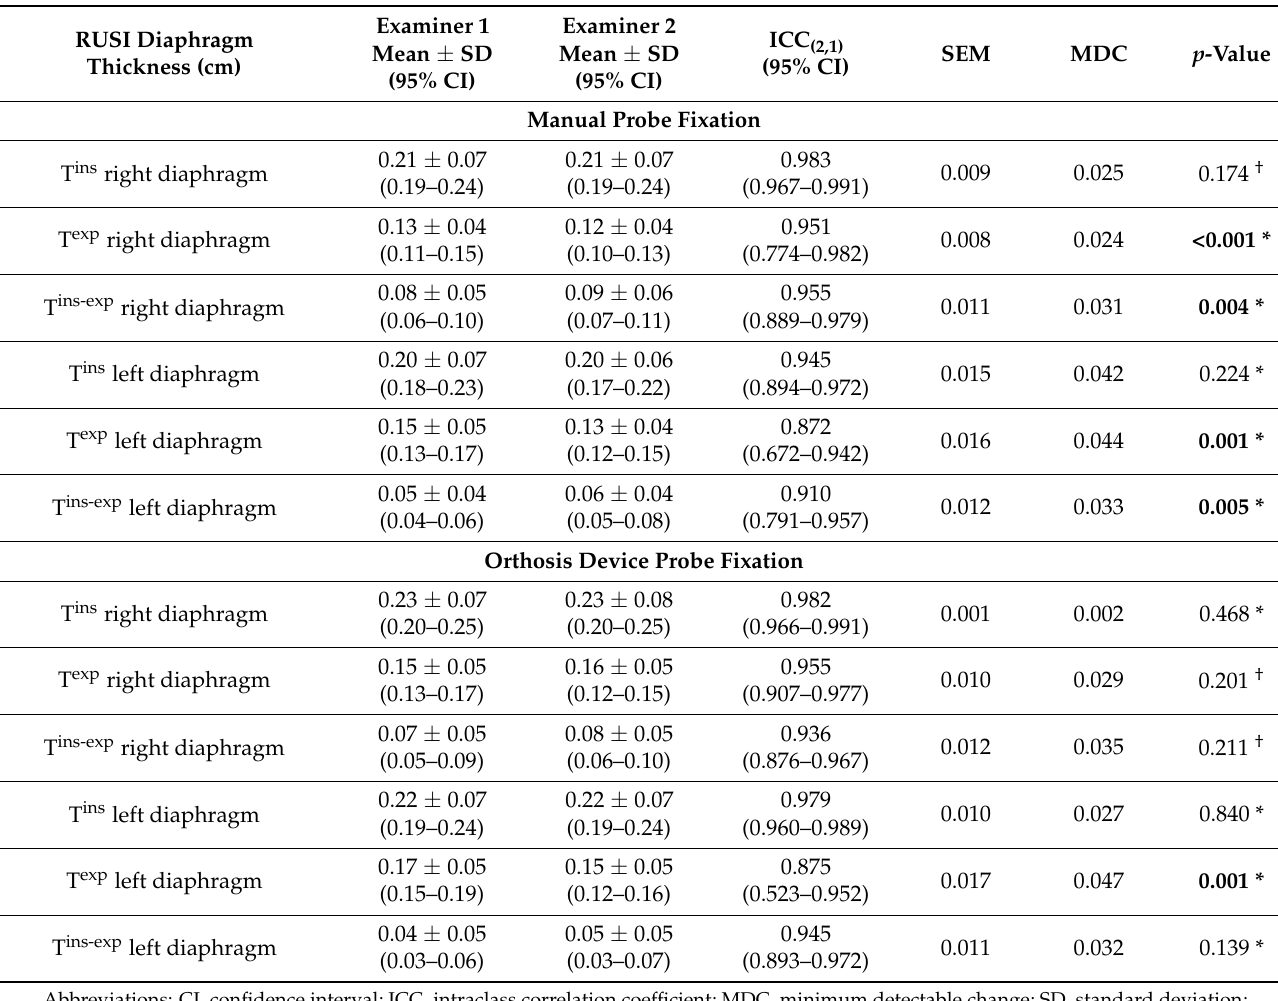
Table 3. Inter-rater and intra-session reliability analysis for RUSI diaphragm thickness within both manual and specific orthosis device measurement methods during relaxed